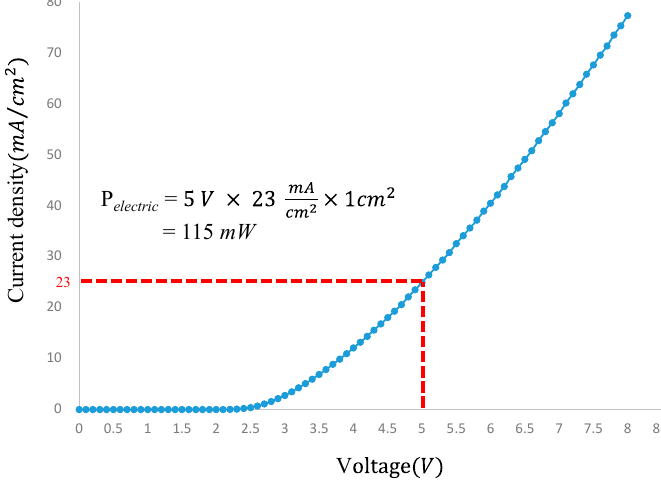
Figure. 4. Average J-V curve. Figure 4. Average J-V